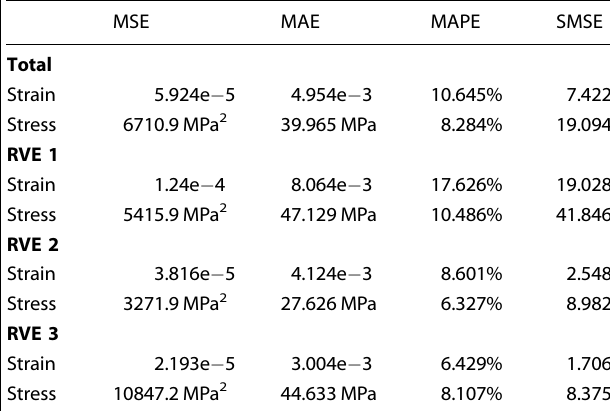
Table 2. Three hundred grain RVE error metrics.